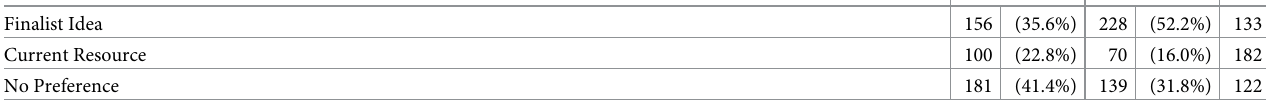
Comparison Comparison 1: Supports 2: Campus 3: for graduate tours students